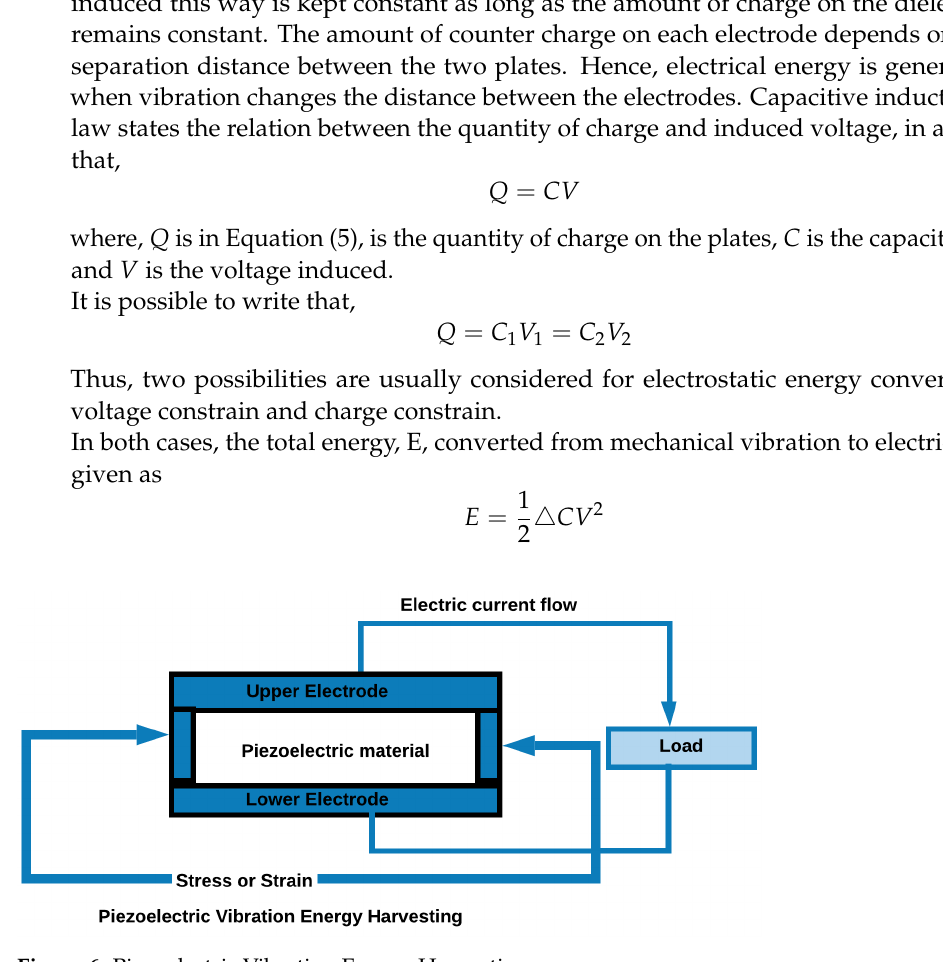
Figure 6. Piezoelectric Vibration Energy